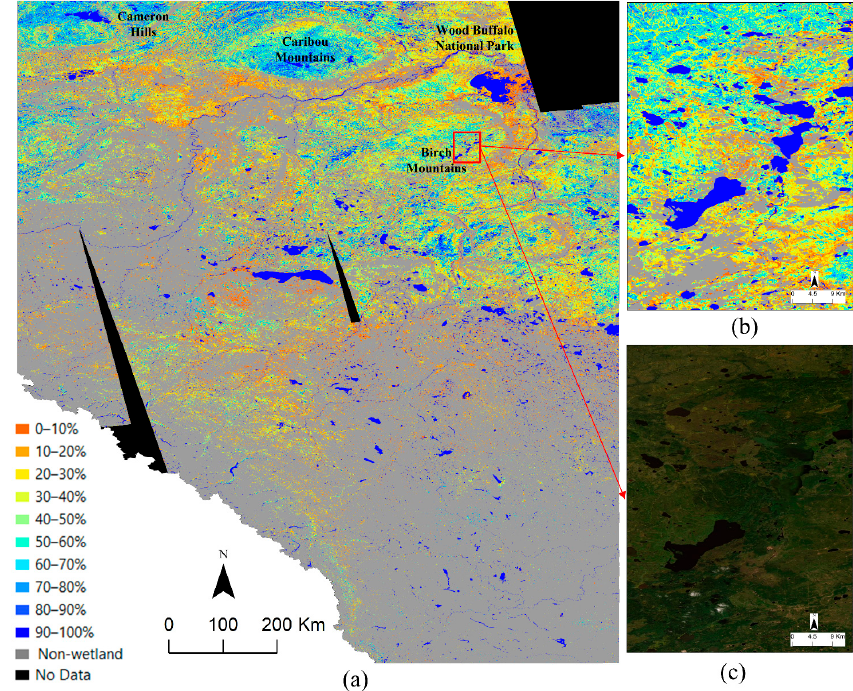
Figure 7. ( a ) Hydroperiod map of wetlands in Alberta (based on percentage) using coherence prod- ucts of 2017–2020; ( b ) a zoomed map from a portion of the Birch Mountains; ( c ) the corresponding high-resolution satellite image exported from ArcGIS software. Table 2. Areas of flooded wetlands between 2017 and 2020 for different hydroperiod categories. Flooded Percentage Category